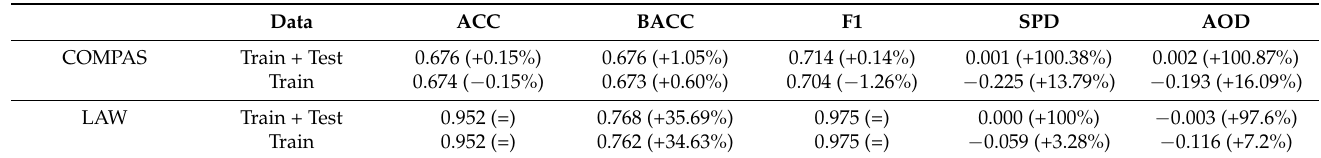
Table 9. Performance results for LRC on augmented data, performing stratified 10-fold CV. For SPD and AOD, values closer to zero indicate more fairness. The results correspond to maximal fairness achieved by data augmentation based on [10]. The percentages in brackets display the differences compared to the baseline results as presented by Table